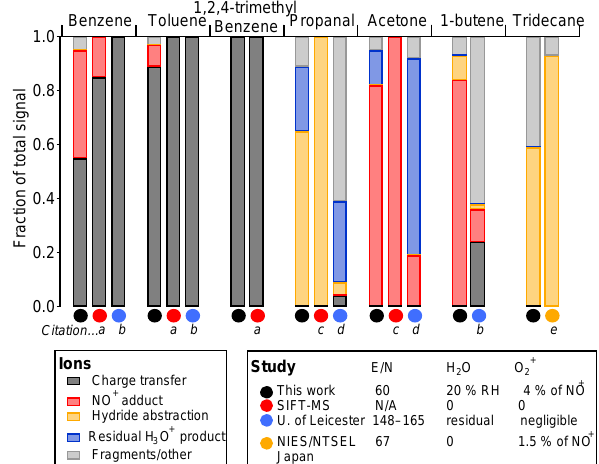
Figure 5. Comparison of product ion distributions between four sets of instrumental and environmental conditions. References: